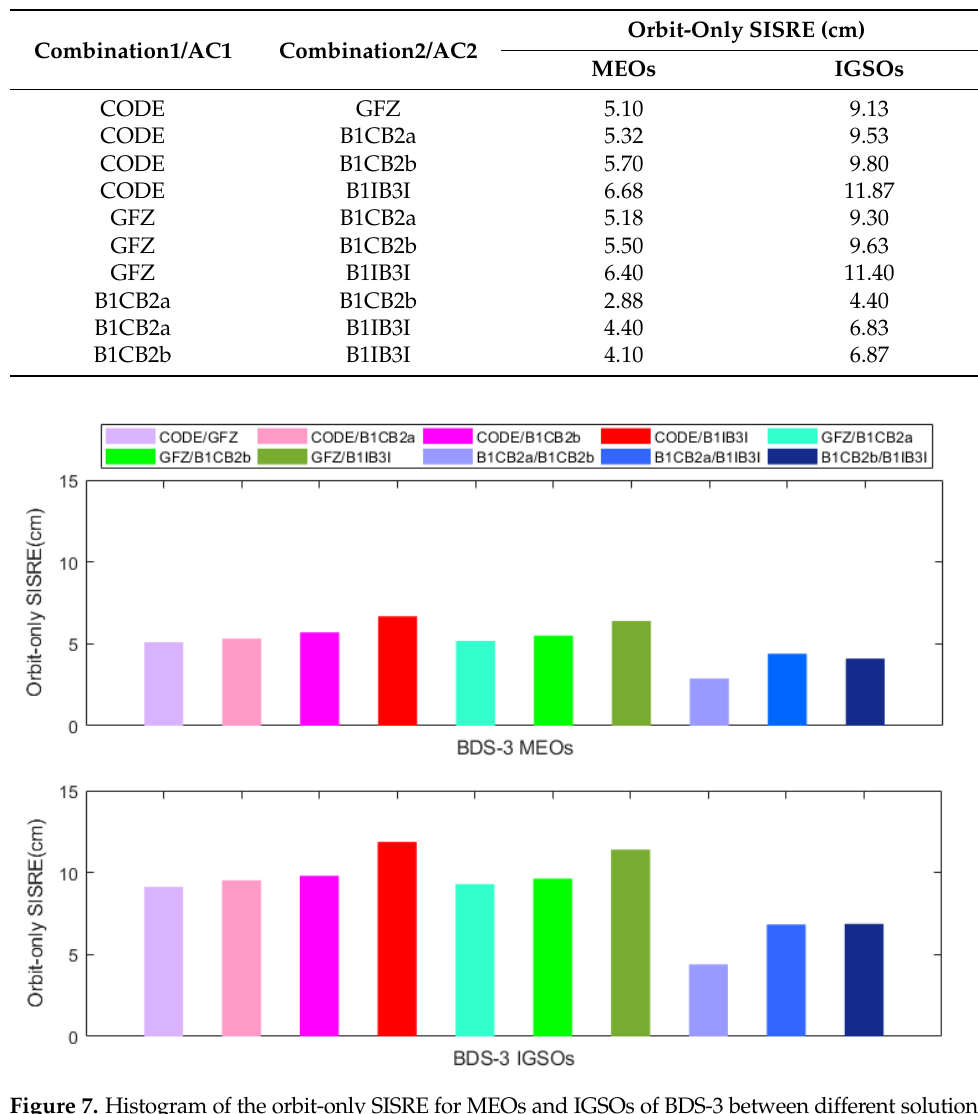
Table 4. Orbit-only SISRE for MEOs and IGSOs of BDS-3 between different solutions.